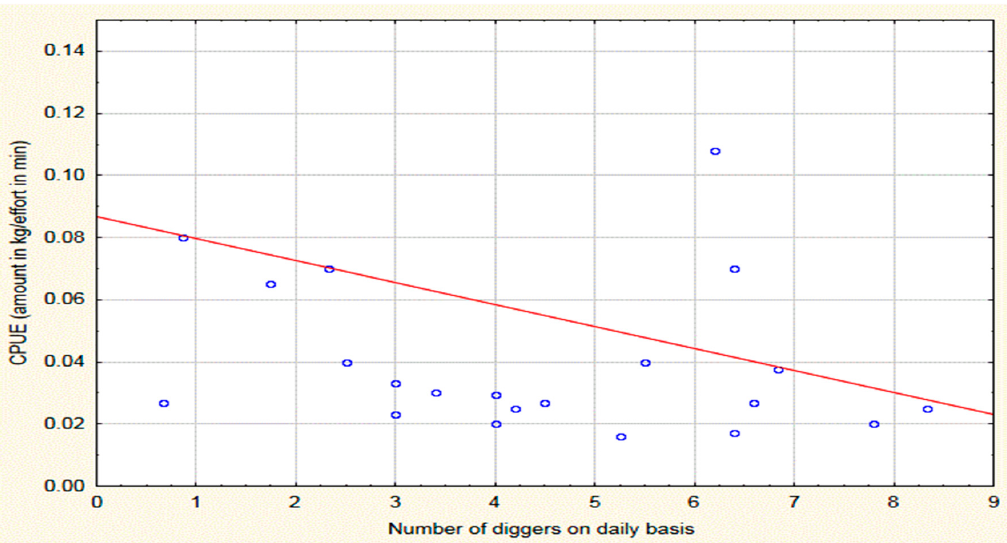
Figure 4. Catc h Per Unit Effort (CPUE) calculated in number of baitworms captured as a function of the number diggers on daily basis in Aveiro lagoon for the surveying period 2012–2013.